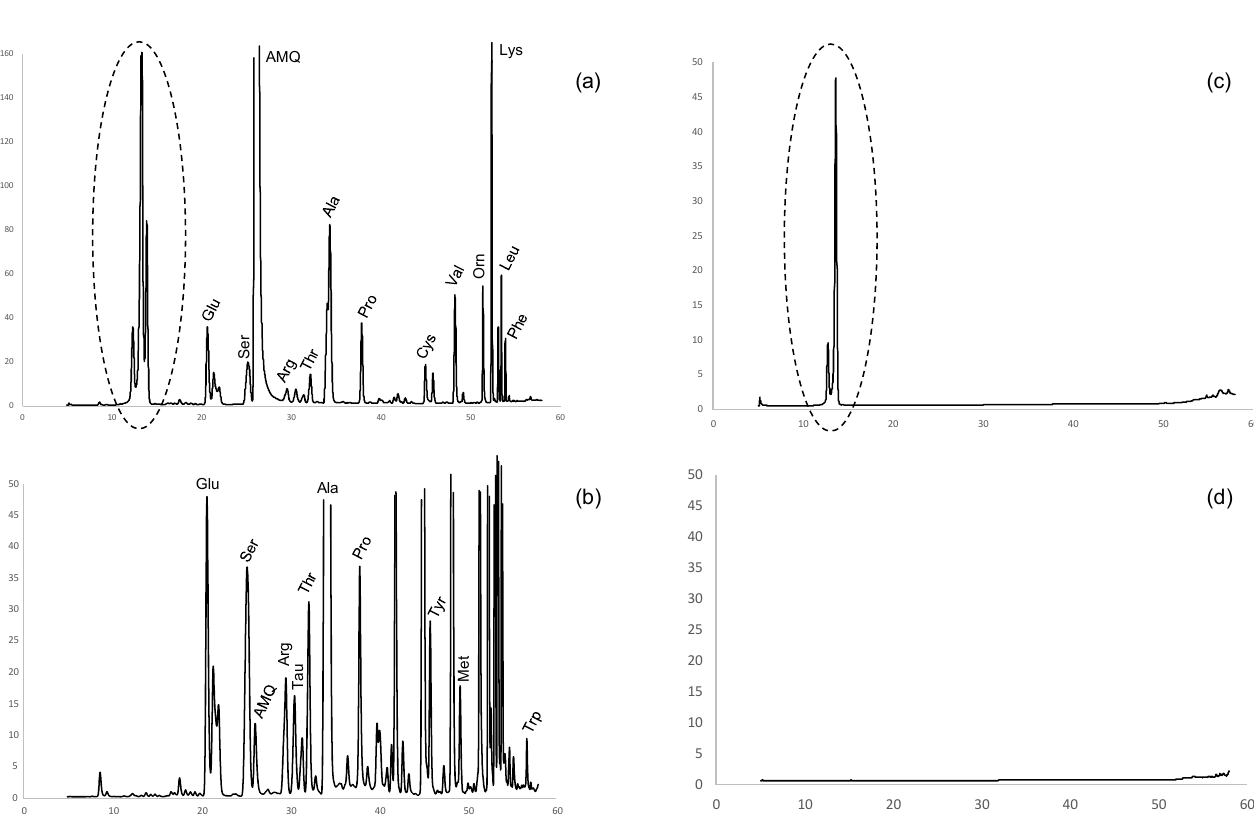
Figure 1. HPLC-UV-FL chromatograms obtained in the analysis of a treated patient at time 1 (2 h after rt-PA): ( a ) Derivatized plasma sample with UV detection at 254 nm, ( b ) derivatized plasma sample with fluorescence detection, ( c ) non-derivatized plasma sample with UV detection, and ( d ) non-derivatized plasma sample with fluorescence detection. The dashed circle marks the new compounds detected. Individual standard solutions of each amino acid were used for the determination of the retention times of these compounds with UV and FL detection. The assignation was confirmed with the ESI-MS results obtained applying the HPLC-MS method for derivatized samples.